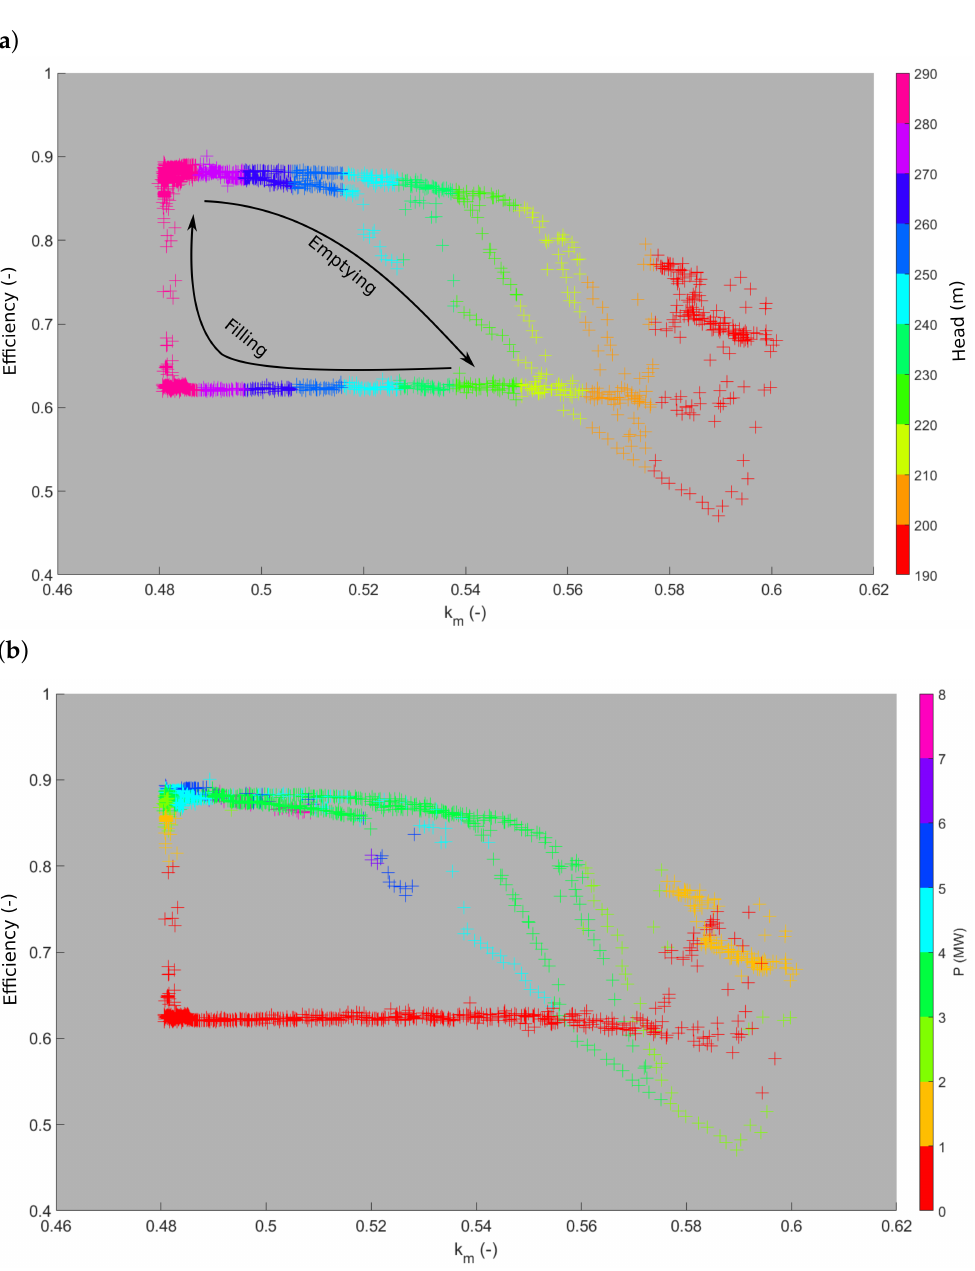
Figure 15. ( a ): Efficiency as a function of the peripheral speed coefficient k m colored by the head. ( b ): Idem as at the top but the symbols are colored by the power demand. The emptying and filling phases are identical for the two